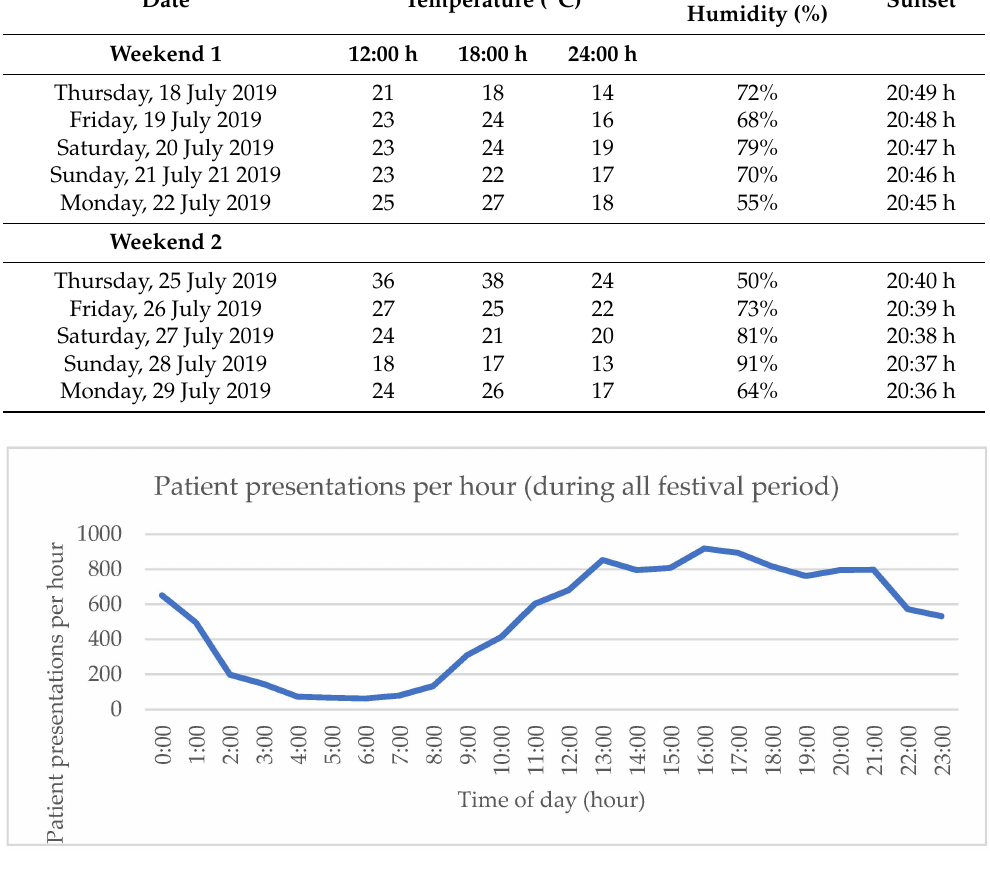
Figure 2. Patient presentations per hour to